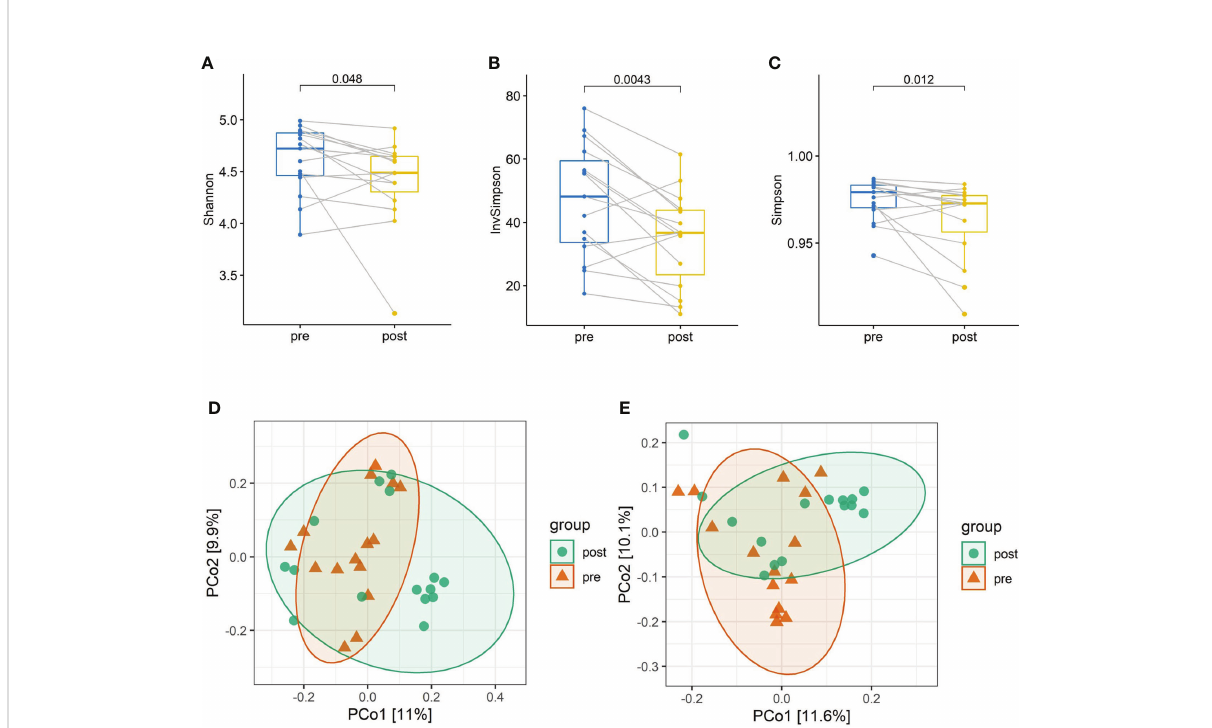
FIGURE 2 The alpha-diversity and beta-diversity analysis between pre-antibiotics and post-antibiotics groups. Paired comparison of alpha-diversity indexes including (A) Shannon, (B) Inverse Simpson, and (C) Simpson index in the two groups. Microbial communities of samples obtained from the post-antibiotics group display signi fi cantly lower diversity than the pre-antibiotics group. Principal coordinates analysis (PCoA) based on Jaccard distance (D) and Underweighted distance (E) shows dissimilarity of microbial communities between pre-antibiotics and post-antibiotics